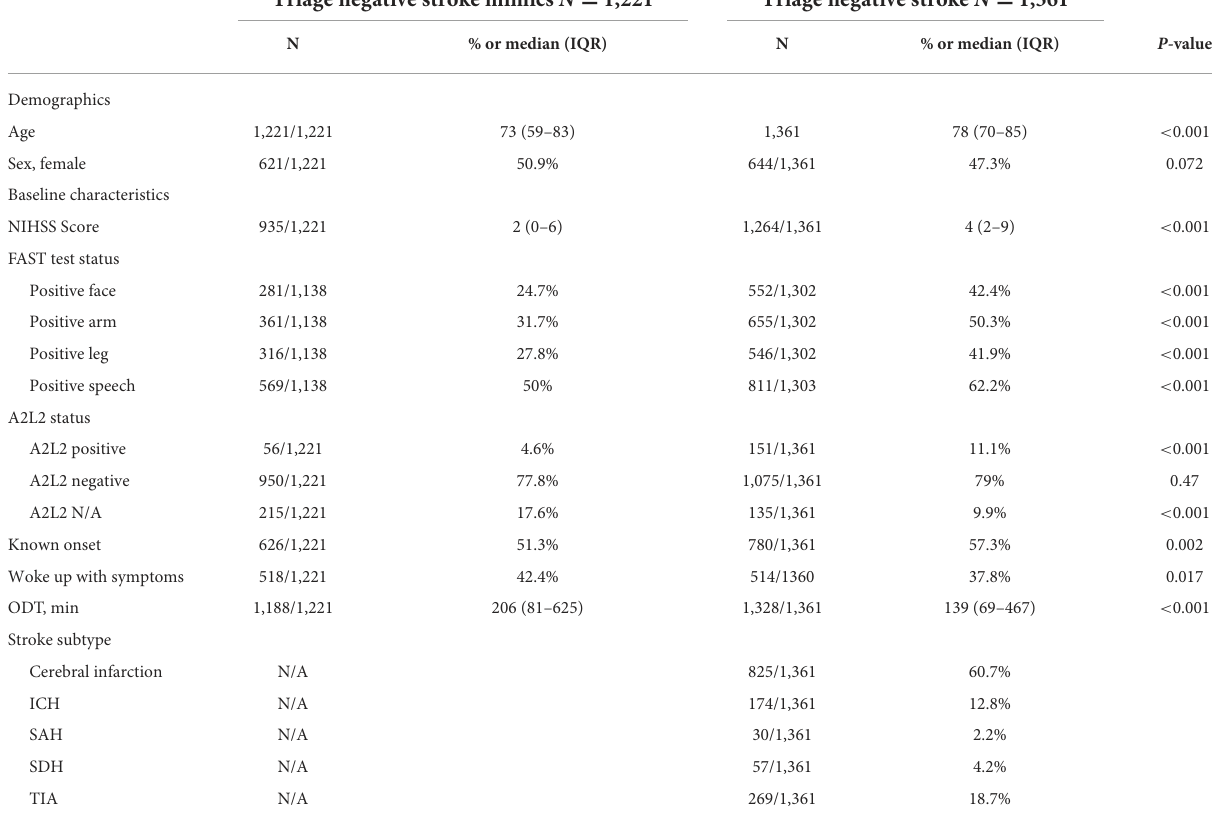
TABLE 2 Comparison of triage-negative stroke mimics vs. triage-negative stroke. Triage negative stroke mimics N = 1,221 Triage negative stroke N =